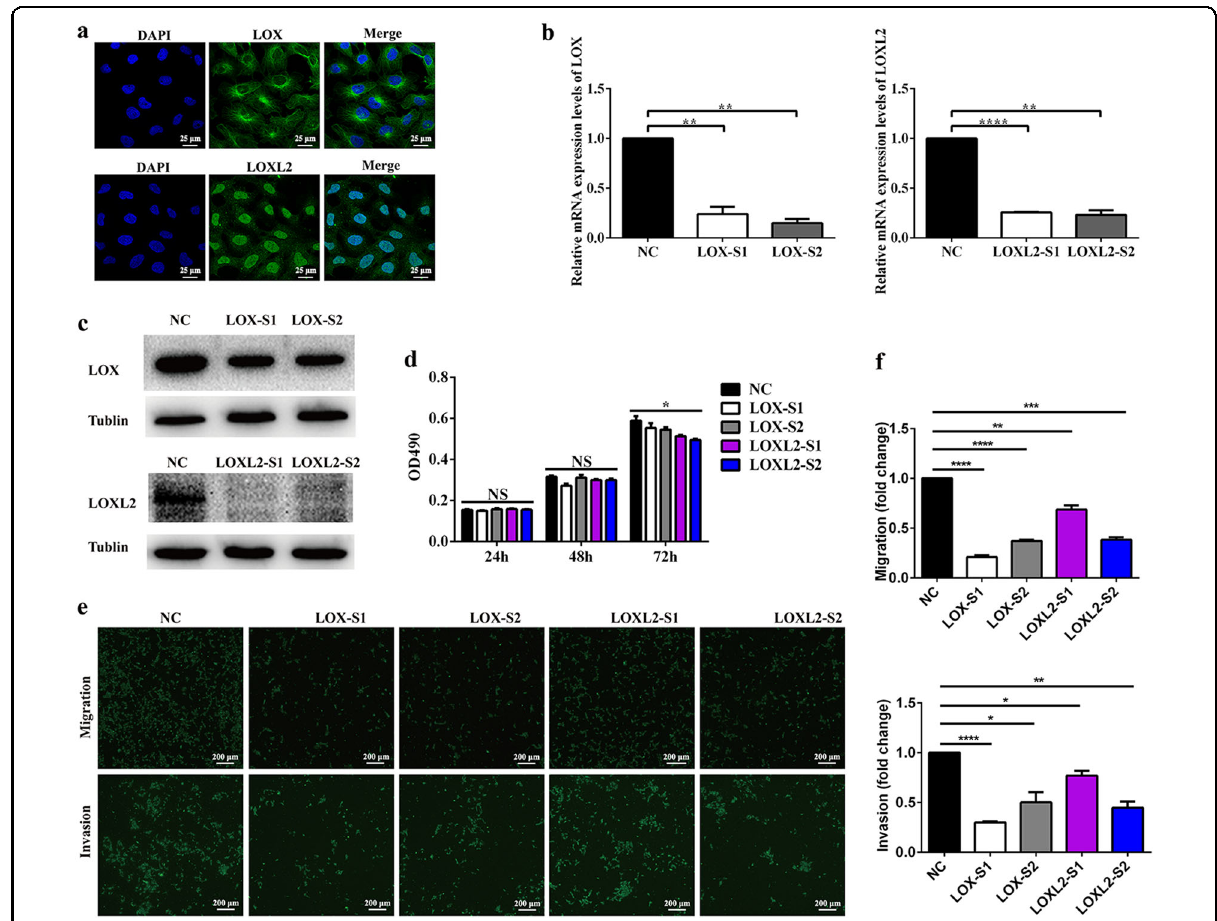
Fig. 2 Knockdown of LOX or LOXL2 decreased trophoblast cell migration and invasion. a Immuno fl uorescence staining for LOX and LOXL2 in HTR-8/SVneo cells. Confocal microscopy images were shown. Scale bar = 25 μ m. b mRNA expression of LOX and LOXL2 in HTR-8/SVneo